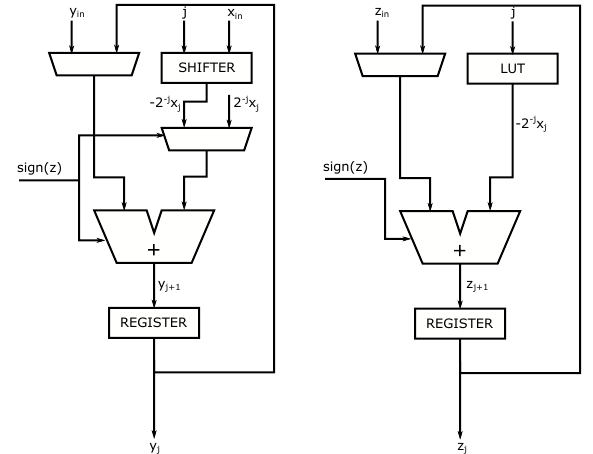
Figure 12. Digital architecture of the linear vectoring